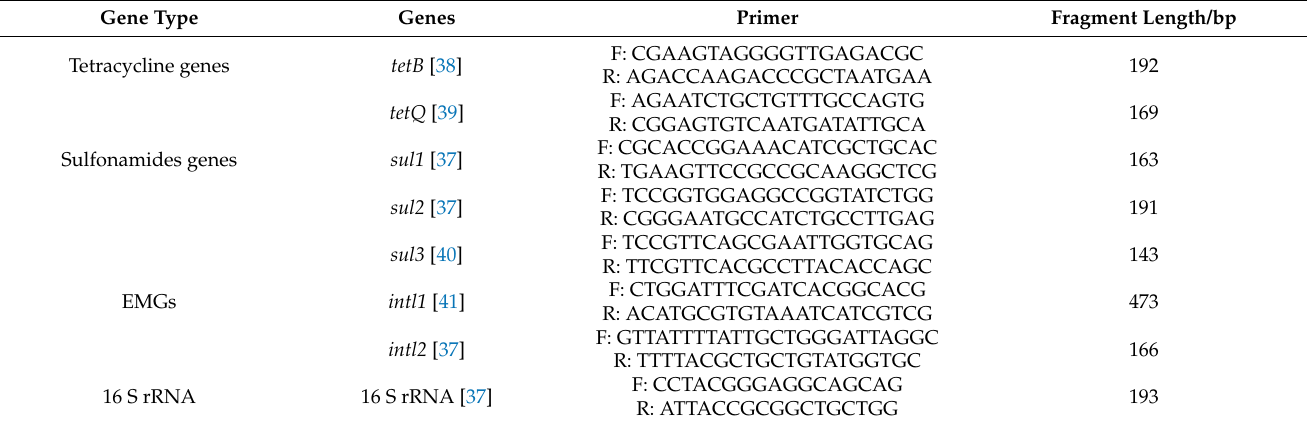
Table 3. Properties of targeted gene